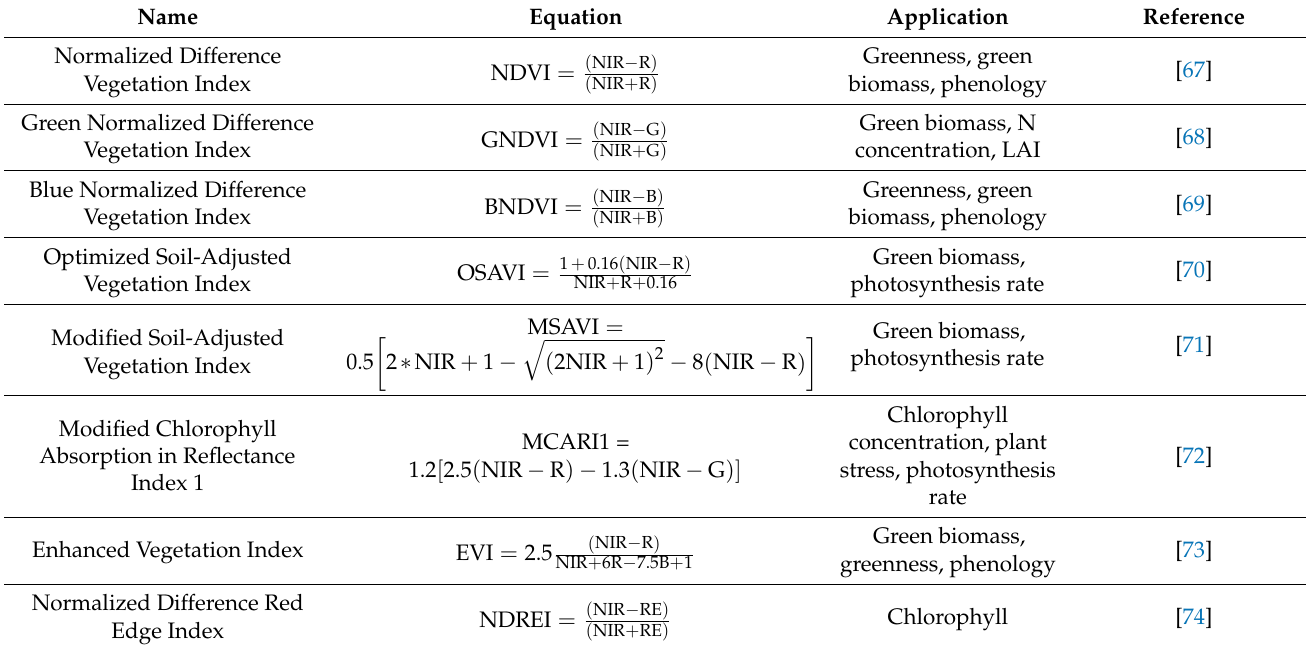
Table 2. Vegetation indices derived from the visible-to-near-infrared spectral